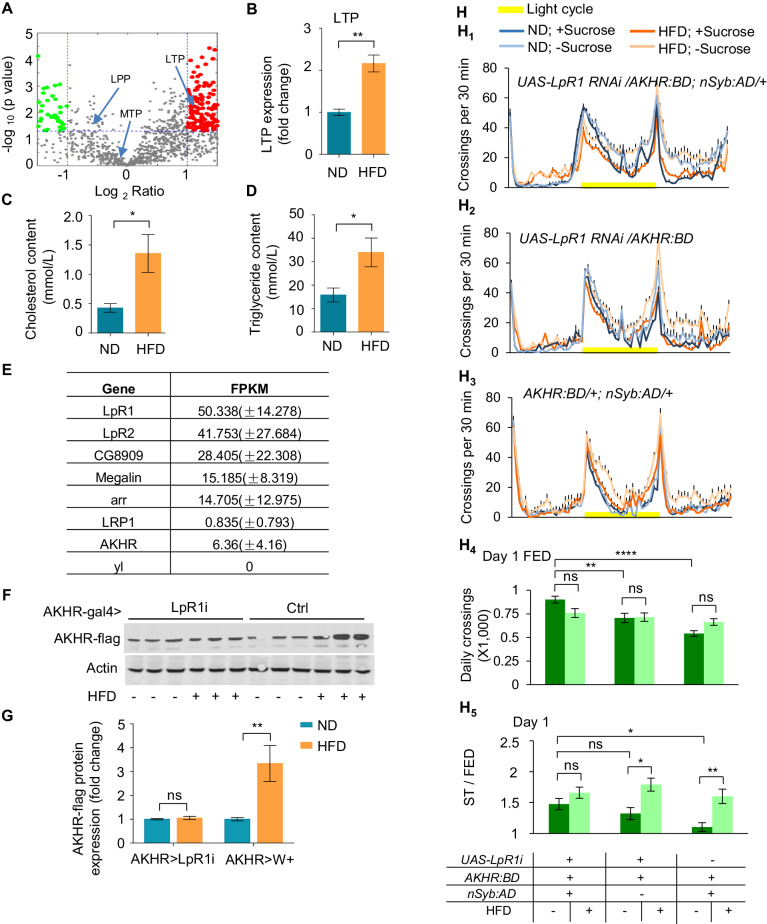
LpR1 is required for HFD-strengthened hyperactivity under starvation.(A–B) LTP protein levels in the hemolymph. Hemolymph was collected from flies fed with ND or HFD and subjected to LC-MS/MS analysis. Volcano plot (A) shows peptides with differential enrichment (under ND vs. HFD feeding conditions). The horizontal line indicates the significance threshold (p=0.01) and the vertical lines indicate two-fold change. Green and red dots represent down-regulated and up-regulated peptides, respectively. Arrows indicate three lipoproteins (LTP, LPP and MTP). The level of LTP was shown in B (n = 3 biological replicates, each containing ~300 flies). (C–D) The cholesterol level (C) and triglyceride level (D) in the hemolymph harvested from ND vs. HFD fed flies (n = 4–6 biological replicates, each containing 60 flies). (E) Single cell RNAseq shows the gene expression level of candidate lipoprotein receptors in AKHR+ neurons (n = 5 cells). (F–G) AKHR protein levels from the head tissues of the indicated genotypes fed with ND or HFD (n = 3 biological replicates, each containing 25 flies). (H1–H3) Midline crossing activity of indicated genotypes and diet treatments assayed in the presence or absence of 5% sucrose (n = 43–57). (H4) Average daily midline crossing activity of fed flies assayed in H1-H3. (H5) Starvation-induced hyperactivity of flies assayed in H1-H3. ns, p>0.05; *p<0.05; **p<0.01. Student’s t-test, one-way and two-way ANOVA followed by post hoc test with Bonferroni correction were used for multiple comparisons when applicable.Figure 7—source data 1.Raw data of the behavioral experiments and mass spec experiments shown in Figure 7.Figure 7—source data 2.Top differentially expressed peptides upon HFD feeding.Wild-type virgin female flies were fed with ND or HFD for 5 d before their hemolymph harvested and subjected to LC-MS/MS. Top 40 differentially expressed peptides (20 up-regulated and 20 down-regulated) were shown.